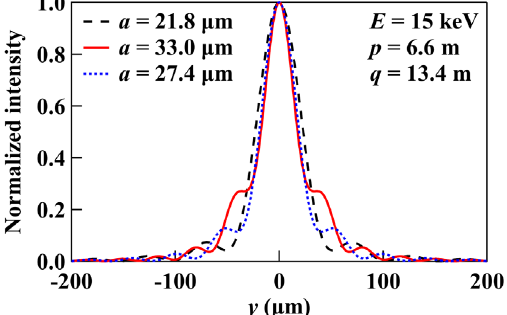
FIG. 3. Simulated PSF of a 1D slit with size a 0 obtained from (dashed curve) analytical formula Eq. (7), (solid curve) minimum profile width from the solid curves in Fig. 2(a), and (dotted curve) minimum Gaussian-fitted width from the dotted curves in Fig. 2(a).